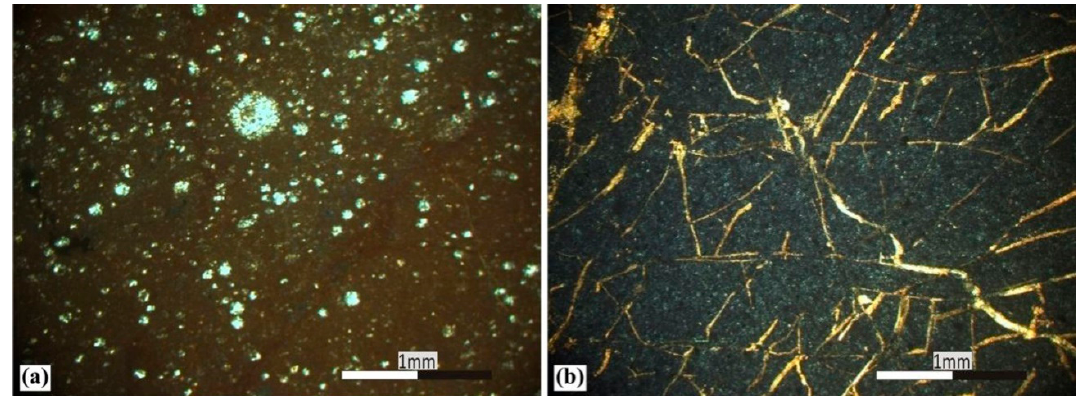
Figure 23. Representative photomicrographs of radiolarites microstructures. ( a ): Characteristic spherical skeleton of radiolarian and presence of iron oxides/hydroxides (brown to red colors) in R1 sample (XPL); ( b ): Network of random microveins filled with carbonates (high birefringence colors) in a siliceous microstructure of R2 sample (XPL).